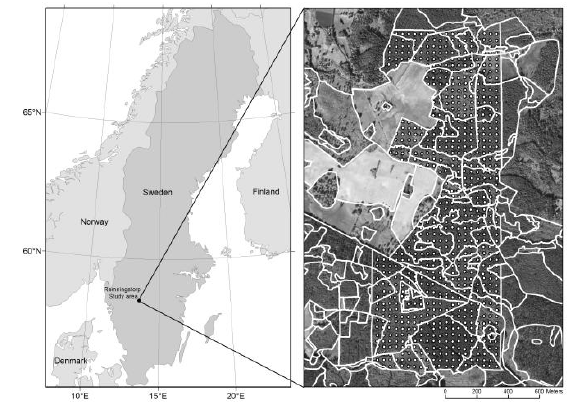
Figure 1. The Remningstorp test site (left) and orthophoto of the area including field plot positions and stand borders